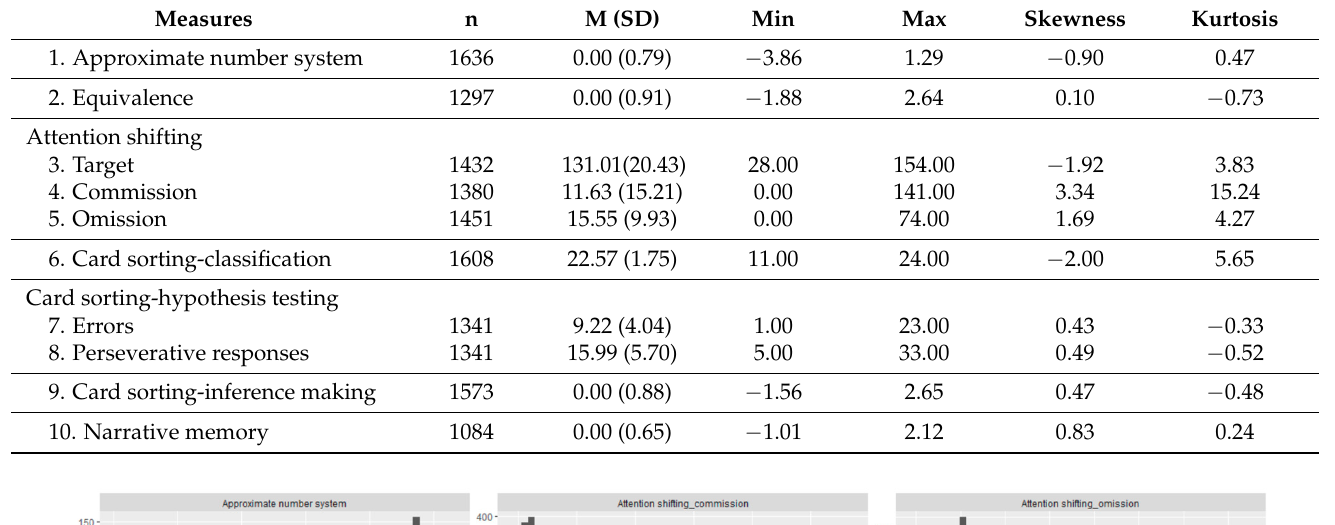
Table 3. Descriptive statistics by subtest case examples.